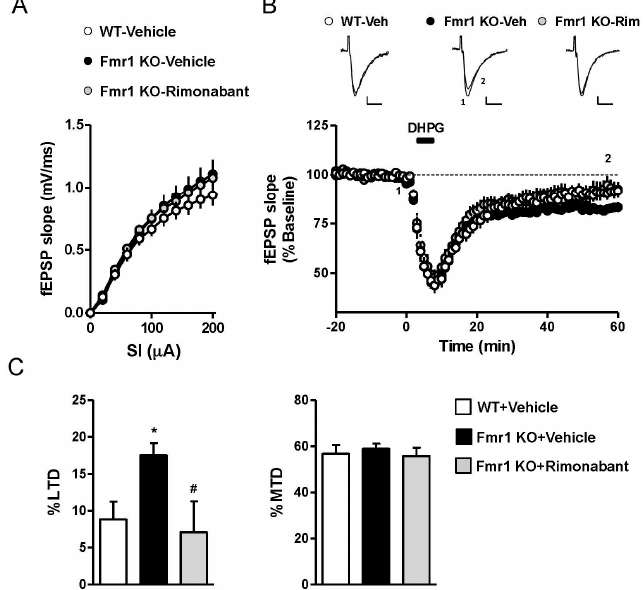
Figure 2. Rimonabant rescues enhanced long-term depression (LTD) in Fragile X Mental Retardation 1 (Fmr1) knockout (KO) mice. Input–output function ( A ) and group I metabotropic glutamate receptor (mGluR) LTD; ( B , C ) were evaluated in hippocampal slices from mice treated with rimonabant (0.1 mg/kg) or its vehicle for 7 days. ( A ) Plots of field excitatory postsynaptic potentials (fEPSPs) elicited in the CA1 region by stimulation of Schaffer collateral projections were not detectably different between Fmr1 KO and wild-type (WT) mice. Subchronic treatment with rimonabant did not modulate basal field responses in Fmr1 KO mice; ( B ) Time-course of fEPSP slopes following bath application of the group 1 mGluR agonist (S)-3,5-Dihydroxyphenylglycine (DHPG) (100 µ M, 5 min). ( C ) LTD and maximum transient depression (MTD) calculated from the experiments depicted in ( B ). LTD was enhanced in Fmr1 KO mice (* p < 0.05 vs. WT mice) and was rescued by subchronic rimonabant ( # p < 0.05 vs. vehicle treatment). Data are expressed as mean ± SEM of 6–10 slices from 3 to 5 mice per condition. Scale bars: 0.1 mV/10 msec.